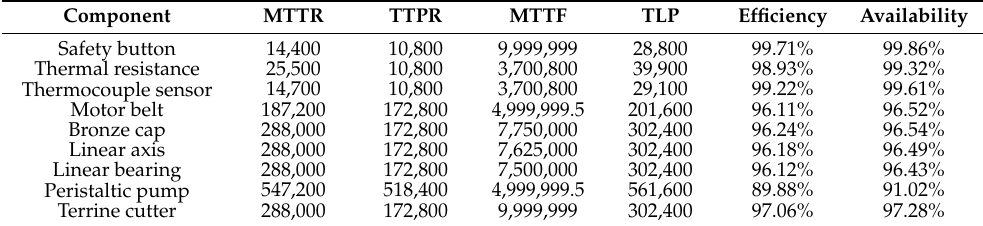
Table 8. Mechanical components times in seconds. Efficiency and availability calculated in % with PPM